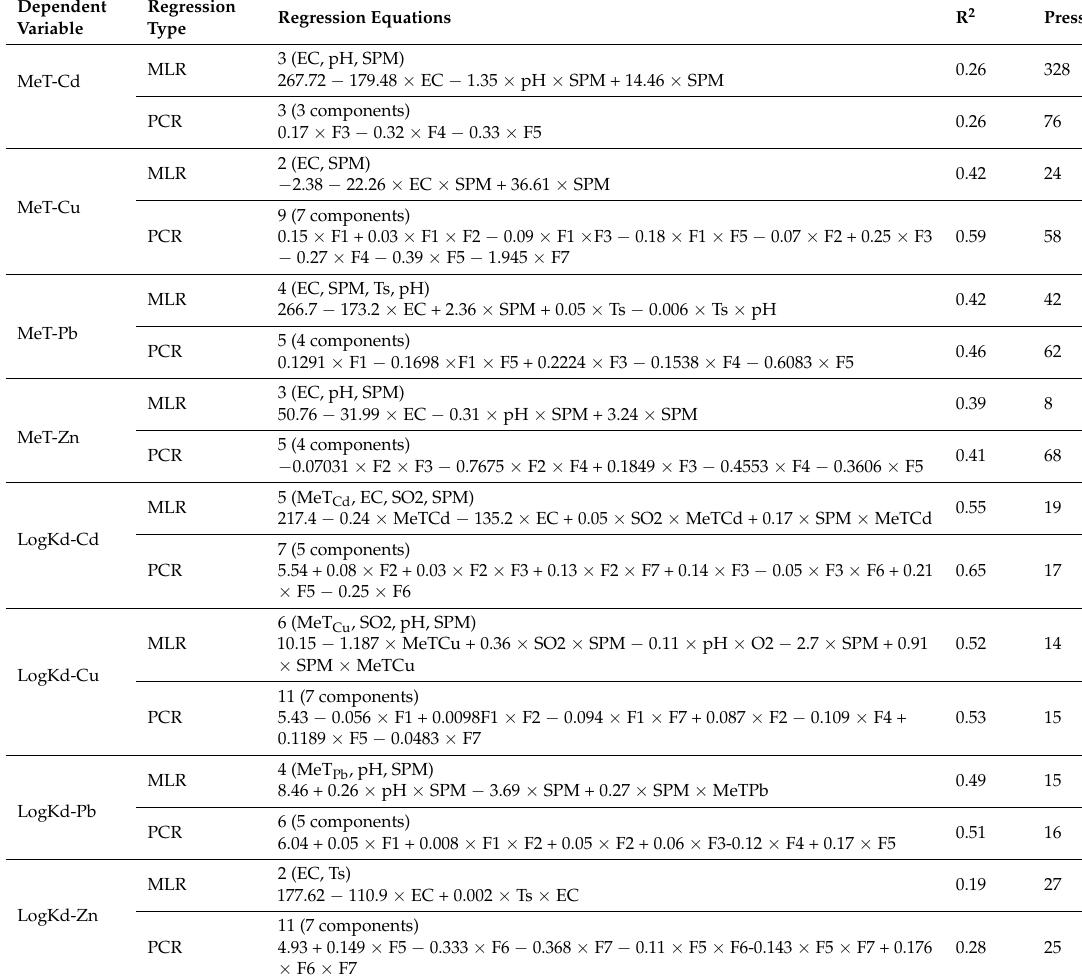
Table 4. Summary of total metal concentration (MeT) and partitioning coefficient (log based: Log K d ) regression equations using the multi-linear regression (MLR) and principle component regression (PCR) techniques at rural catchment runoff discharging